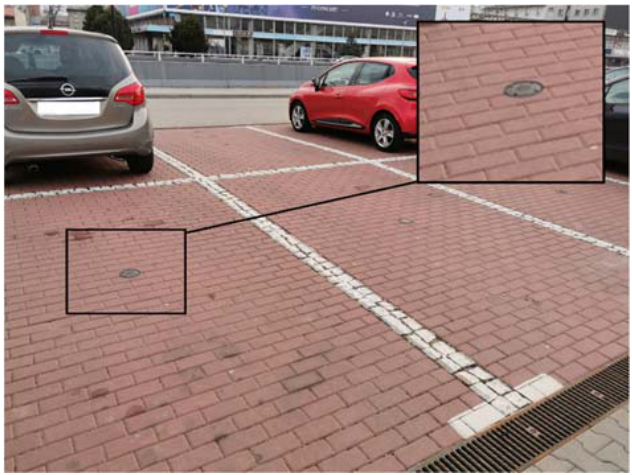
Figure 2. Parking spaces are equipped with a magnetic sensor in PPZ in Gliwice.